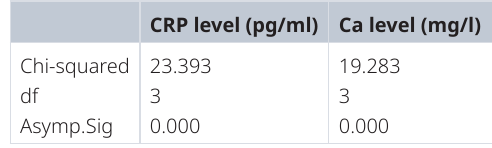
Table 2. Kruskal–Wallis results of CRP and Ca levels.